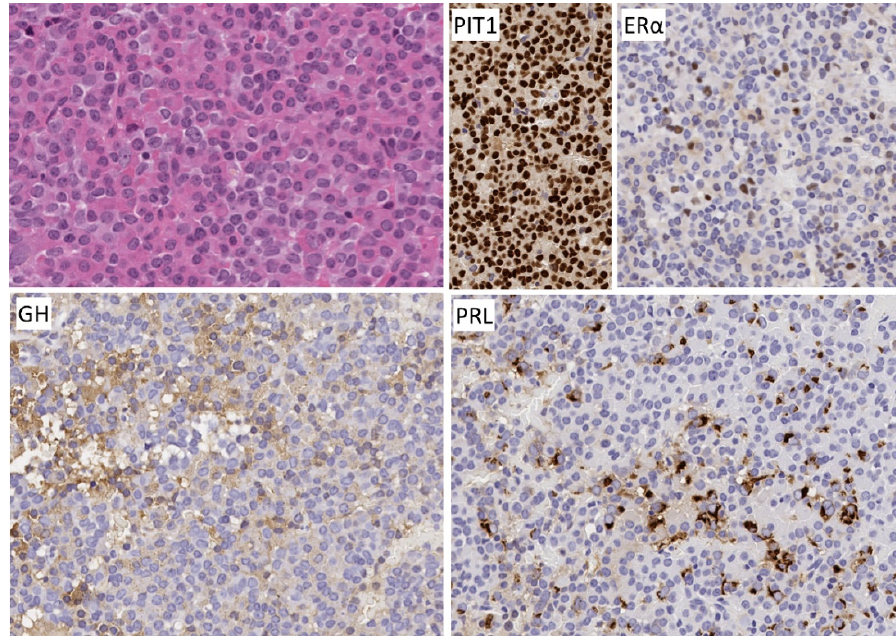
Figure 11. Morphology of mixed densely granulated somatotroph and sparsely granulated lacto- troph tumor. This patient presented with acromegaly and had hyperprolactinemia. The tumor re- sembles a densely granulated somatotroph tumor but also has scattered cells with clear cytoplasm. There is diffuse nuclear positivity for PIT1, but only scattered cells express ER α . Positivity for GH is abundant but there are clearly negative cells that instead represent the clear cells which show juxtanuclear globular reactivity for PRL. The degree of GH excess in patients with these tumors is usually proportional to the GH producing cell mass as well as the type of GH-producing cells that may be densely granulated, as in this case, or sparsely granulated with fibrous